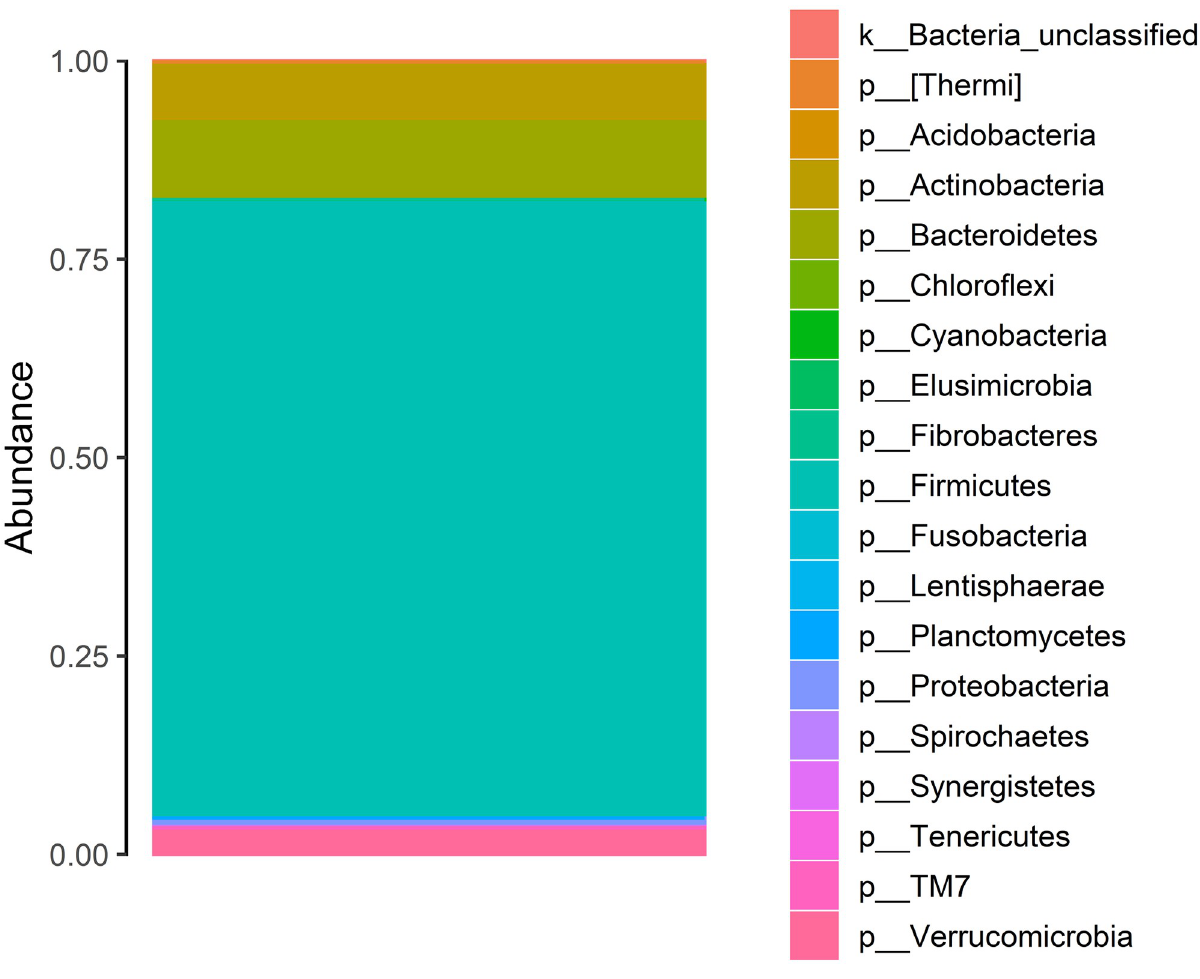
Fig 1. A stacked bar plot demonstrating the relative abundance of phyla in our study.